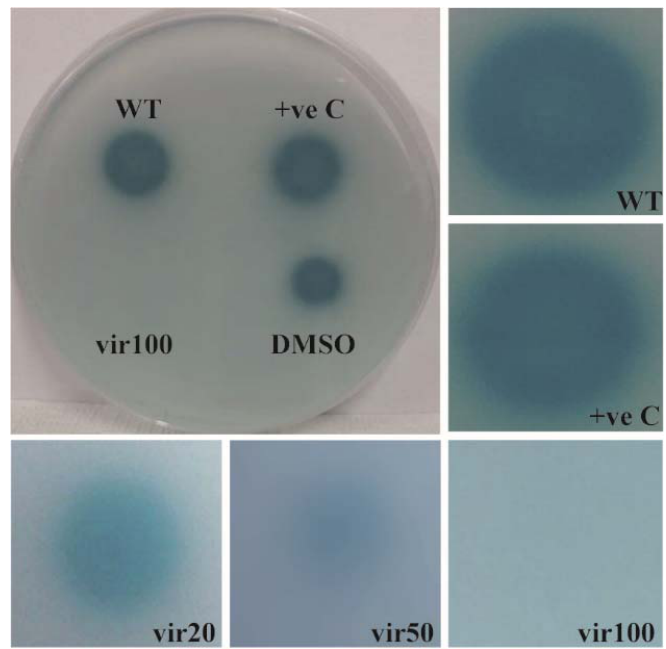
Figure 2. Effect of virstatin on the production of AHL. Bioassay was carried out to check the effect of virstatin on the production of AHLs in A. nosocomialis . For this, the strain was cultivated overnight in Luria Bertani (LB) medium at 30 °C, and the cells were washed with LB and diluted to an OD 600 of 1. The cells were treated with different concentrations of virstatin (20, 50, 100 mM), which was dissolved in dimethyl sulfoxide (DMSO), and 5 µL of the samples were spotted onto chromoplate overlaid with A. tumefaciens NT1 (pDCI41E33) [184,185]. Synthetic N -(3-hydroxy-dodecanoyl)- L -homoserine lactone (OH-dDHL) was spotted as a positive control. The plates were incubated at 30 °C for 22 h, followed by the detection of the color zone surrounding the bacteria. A representative chromoplate image with 100 mM virstatin and images of color zones from different concentrations of virstatin are shown. WT, A. nosocomialis wild type; +ve C, OH-dDHL; vir20, vir50 and vir100; wild-type cells treated with 20, 50 and 100 mM virstatin respectively.